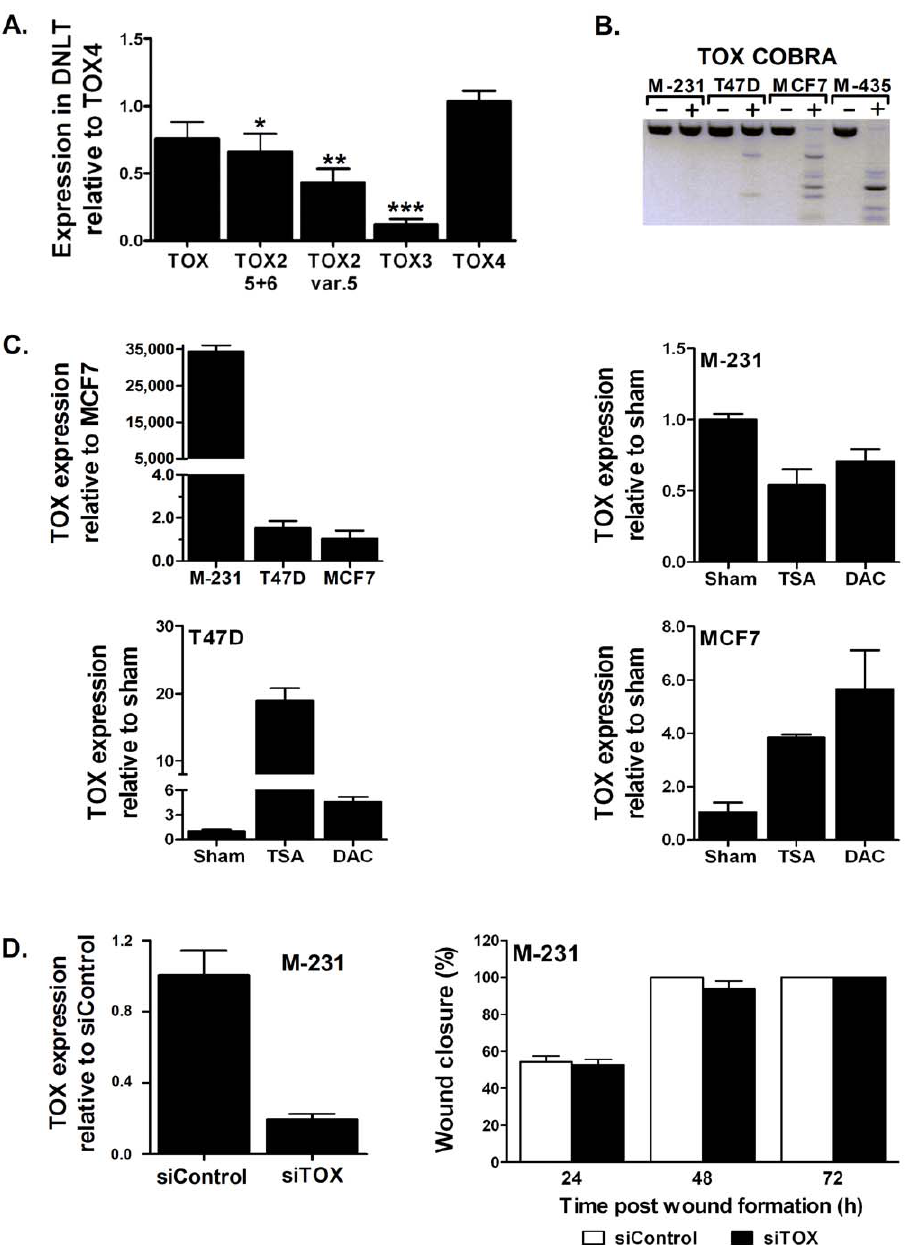
Figure 3. Relative expression of TOX subfamily genes in normal lung tissue. ( A ) Expression of each gene was quantified using TaqMan assays and the level of TOX4 , which is unmethylated in all samples and expressed the highest in normal lung tissue, was used as a reference to calculate the relative level of the remaining genes. * p=0.03, ** p , 0.001, *** p , 0.0001 compared to TOX4 . ( B ) COBRA conducted as described for Figure 1A. ( C ) TOX expression was measured relative to its expression in MCF-7 (Top left) or vehicle treated MDA-MB-231 (M-231) , T47D , or MCF-7 . ( D ) Transfection of M-231 with siTOX reduced its expression by 75% compared to siControl (left) but this did not alter the migration potential of the cells.